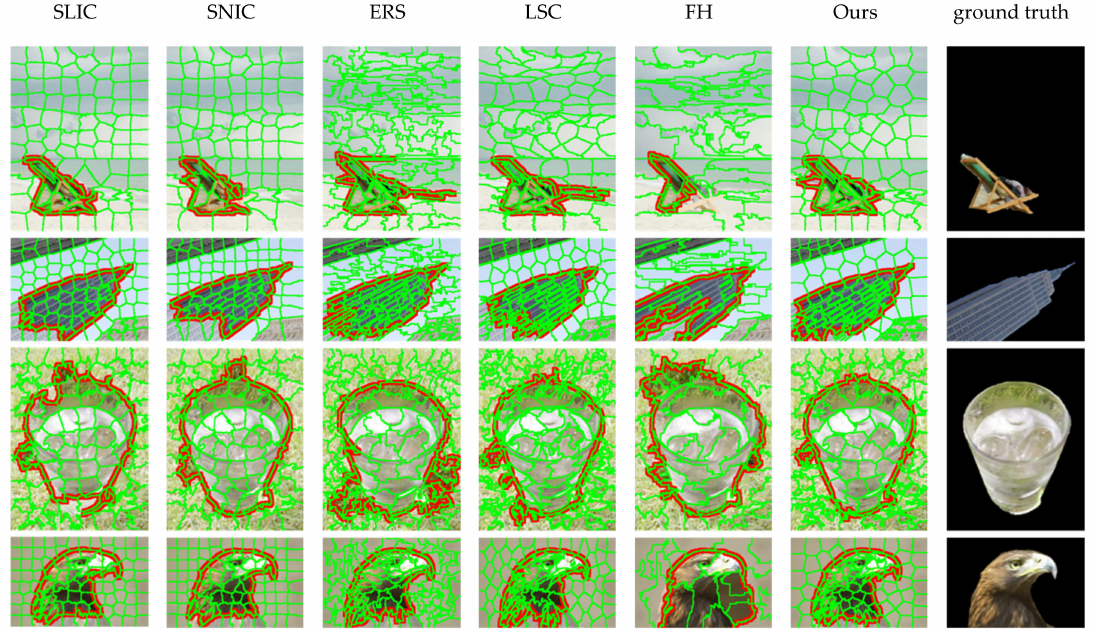
Figure 11. Visual comparison of contour closure results on four examples in Weizmann Segmentation Evaluation Database (WSED). The superpixel boundaries are shown in green, and the closure contours are shown in